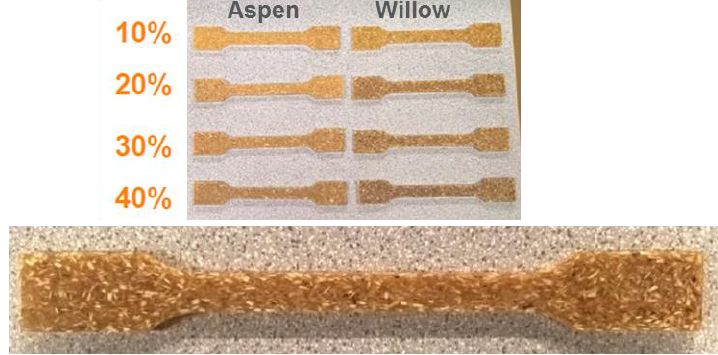
Figure 2. Dog-bone shaped biocomposite test samples of aspen and willow.